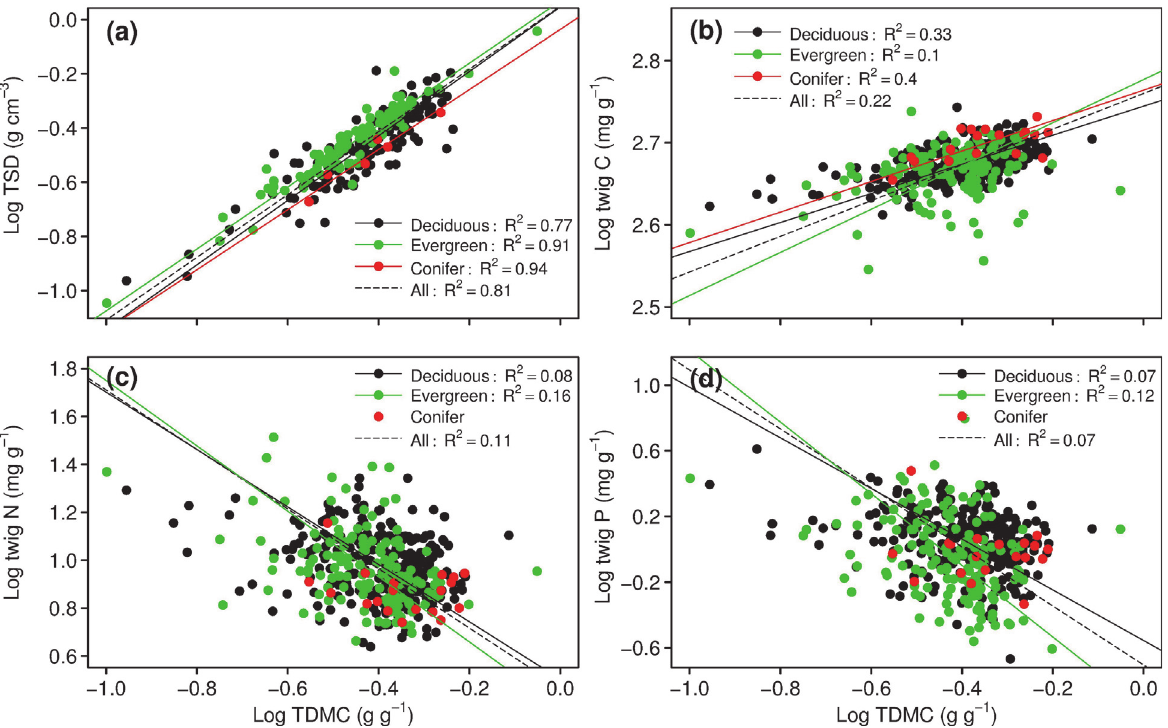
Figure 1. Relationships between twig dry matter content (TDMC) and twig specific density (TSD) and C, N, and P content for different growth forms. (a) TDMC — TSD relationship, (b) TDMC — C relationship, (c) TDMC — N relationship, and (d) TDMC — P relationship. The reduced major axis (RMA) regression is used to fit the